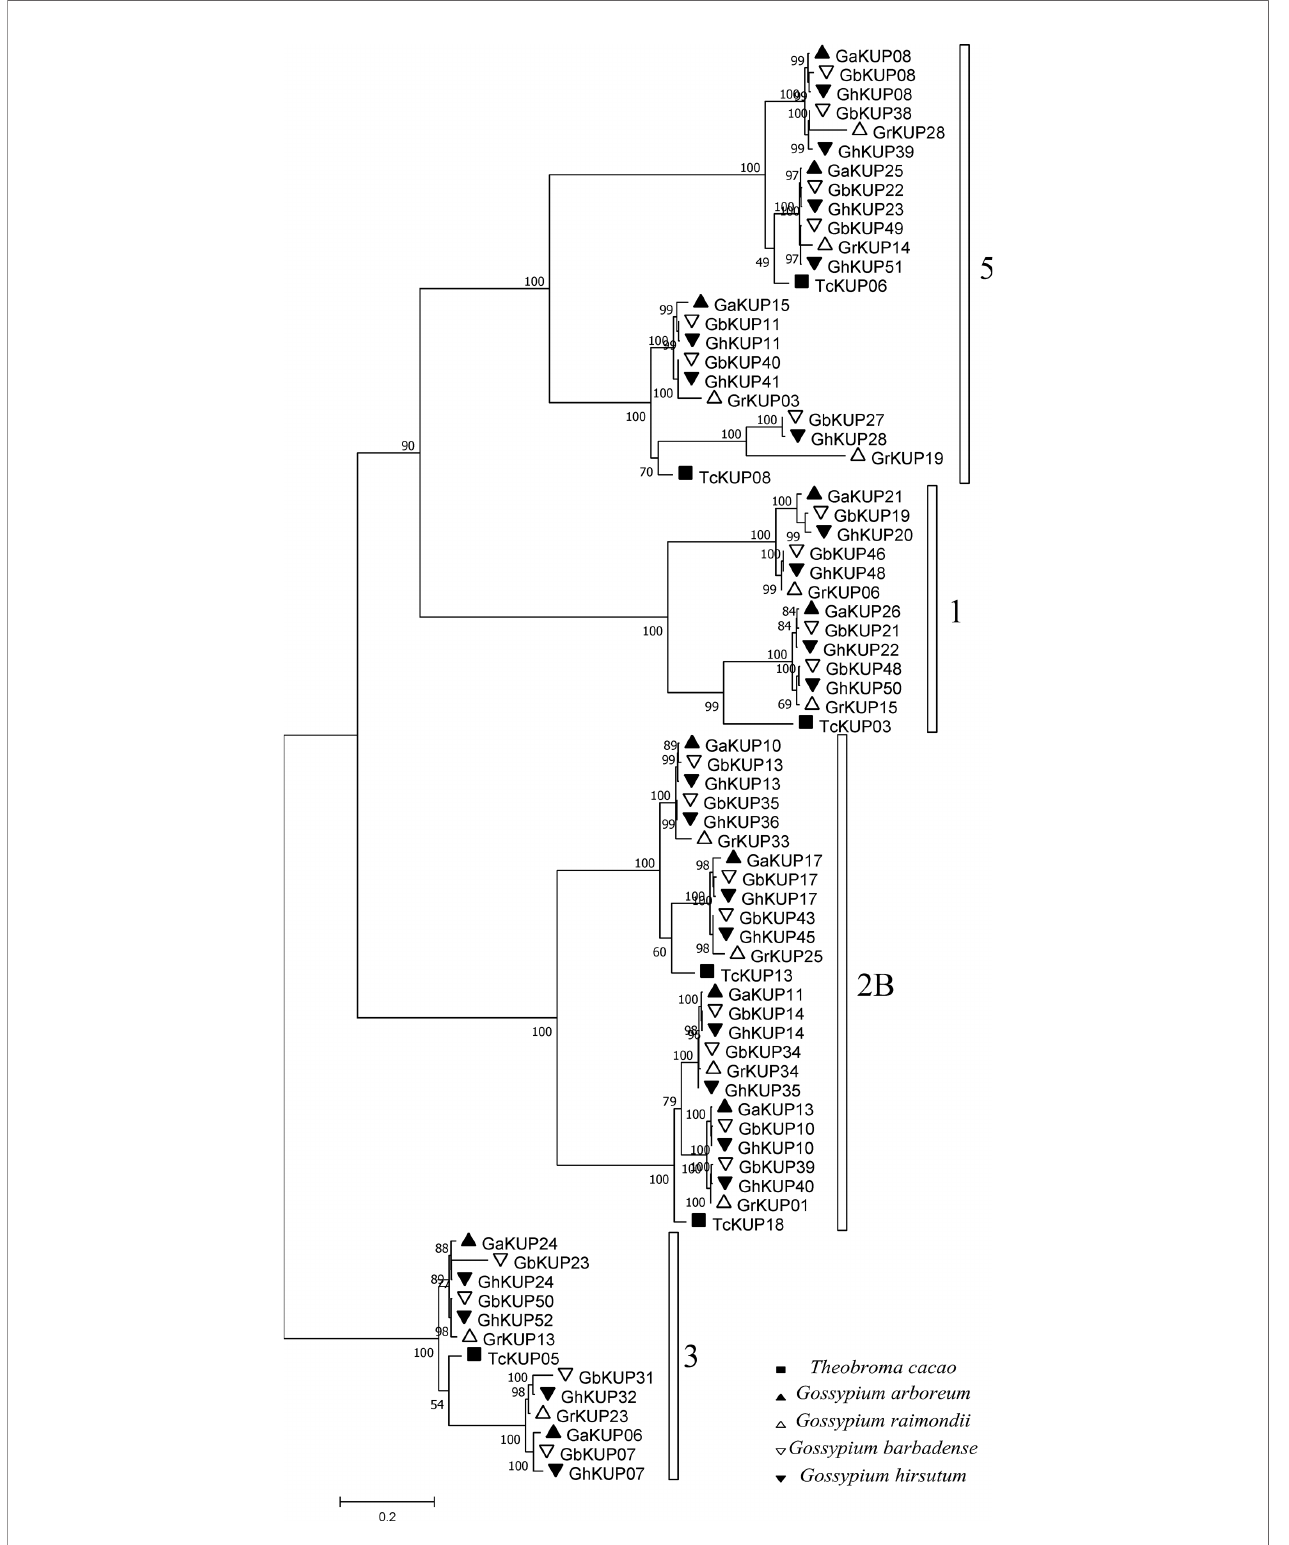
FIGURE 10 | Phylogenetic analysis of duplicated GaKUP s, GrKUP s, GhKUP s, and GbKUP s and their orthologous genes in cacao. The phylogenetic tree was constructed via the ML method. Numbers in clades represent bootstrap values, and KUP subfamilies are indicated by different letters. KUP members from the investigated species are marked by different